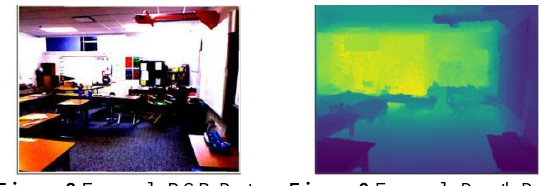
Figure 8. Example RGB Data Figure 9. Example Depth Data